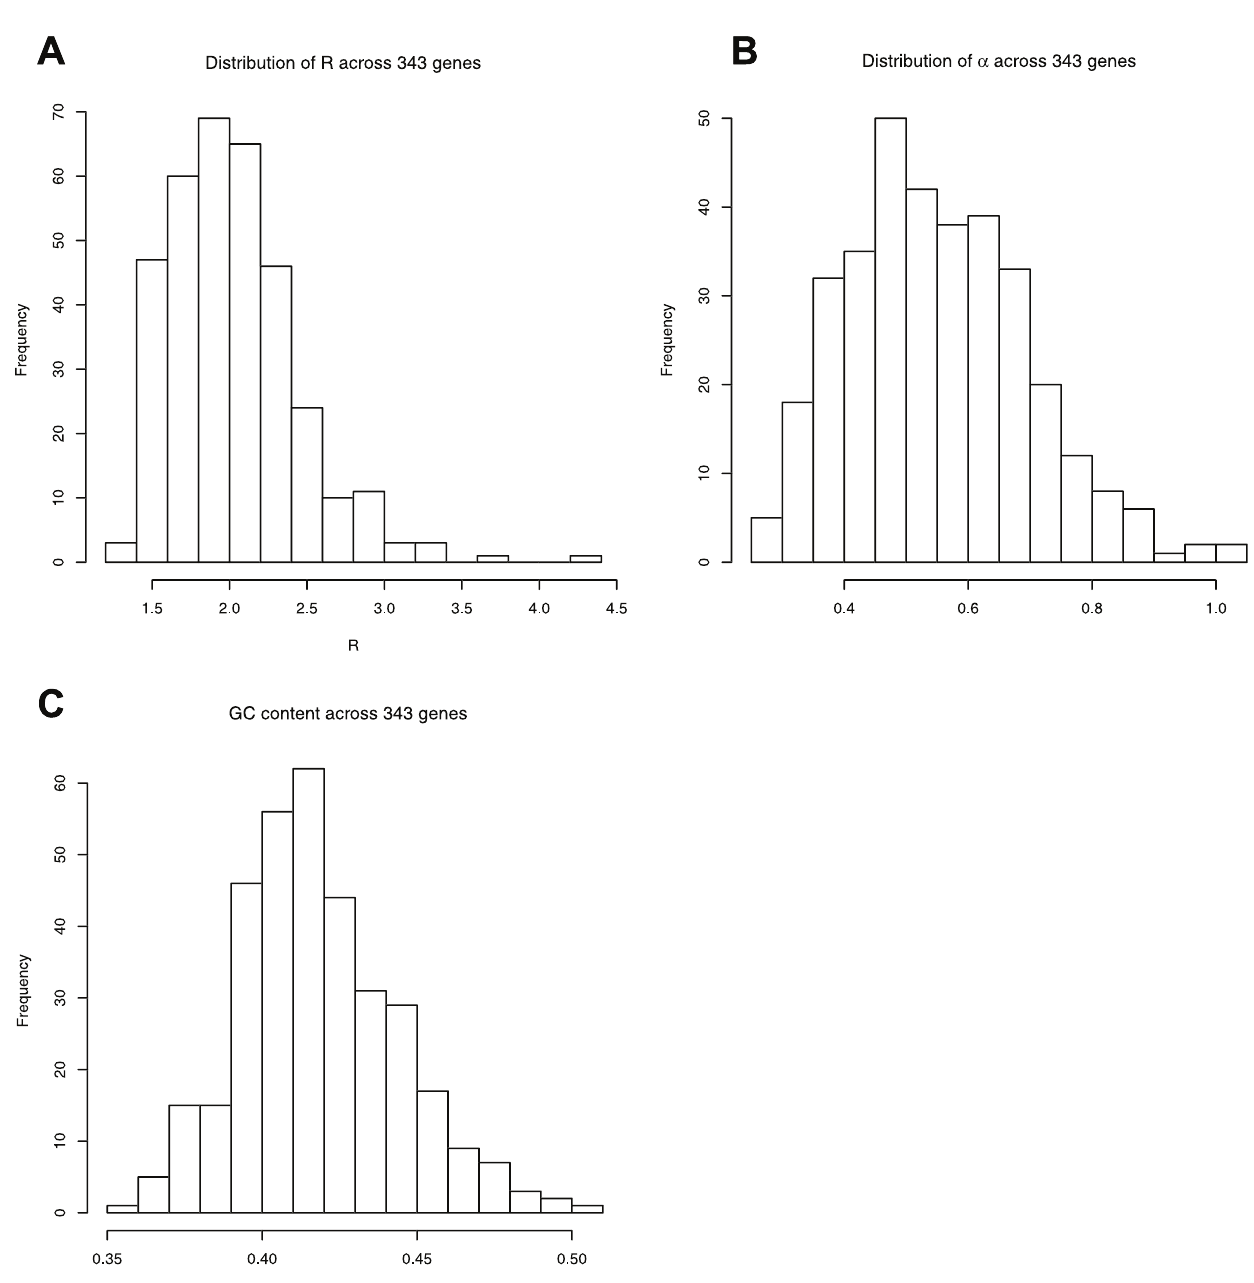
Figure 3. Heterogeneity of parameters estimated across single genes. A: ts/tv ratio ( R ) and B: gamma-distribution shape parameter a , estimated on the ML topology for each of 343 genes (see Methods).